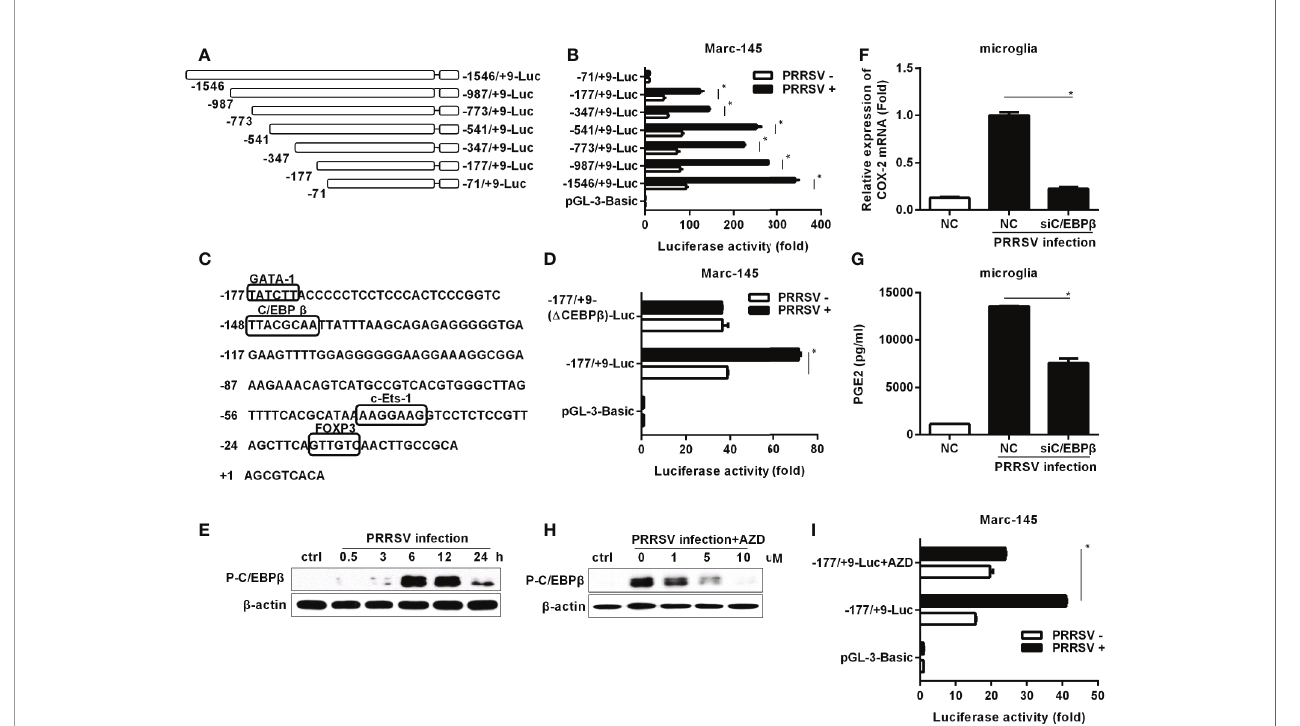
FIGURE 3 | Cloning, sequence analysis, and characterization of porcine COX-2 promoter. (A) Schematic representation of the porcine COX-2 promoter and promoter deletion mutants inserted into pGL3-basic luciferase vectors: -1546/+9-Luc, -987/+9-Luc, -773/+9-Luc, -541/+9-Luc, -347/+9-Luc, -177/+9-Luc and -71/ +9-Luc porcine COX-2 promoter vectors. The relative lengths and positions of the 5 ’ ends of these fragments are indicated. (B) The luciferase reporter vectors or pGL3-basic empty and pRL-TK renilla luciferase plasmids were co-transfected into Marc-145 cells. At 12 hours later, cells were mock infected or infected with PRRSV (MOI, 1), and then cells were harvested to determine luciferase activity at 24 hours post-infection. (C) Sequence analysis of the 186-bp porcine COX-2 gene 5 ’ fl anking regions. The putative transcription factor binding sites were shown in boxes. (D) Marc-145 cells were transfected with the constructed mutant promoter for 12 hours, and then cells were mock infected or infected with PRRSV (MOI, 1). At 24 hours post-infection, cells were harvested for luciferase activity analysis. (E) Microglia were infected with HP-PRRSV strain HV (MOI, 0.1), and cells were harvested for p-C/EBP b analysis at 0.5, 3, 6, 12, and 24 hours